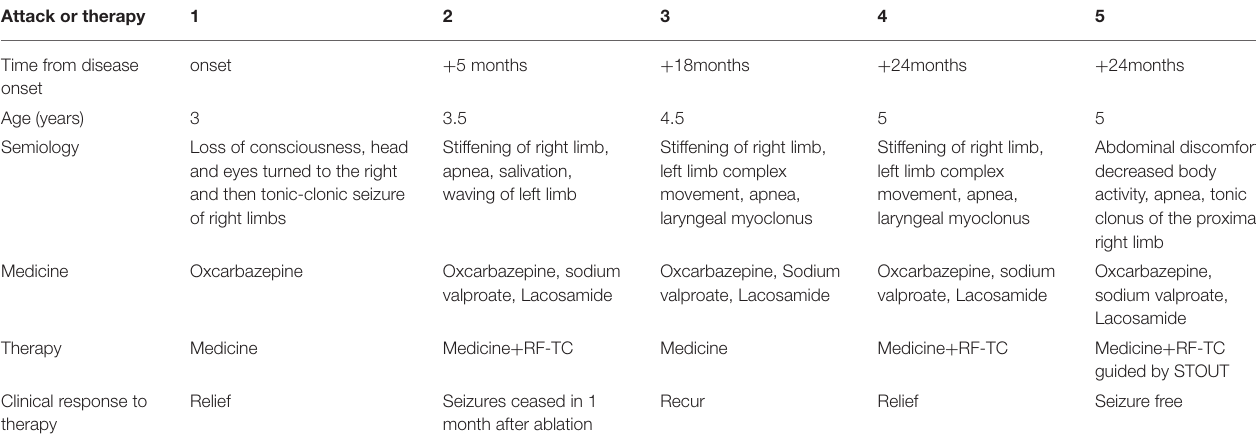
TABLE 1 | Patient’s clinical data of each attack or therapy. Attack or